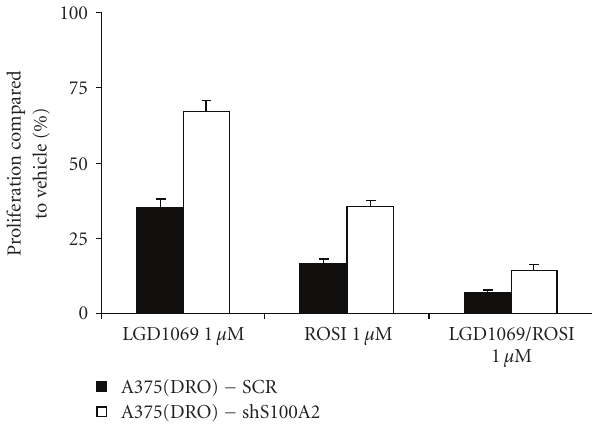
Figure 5: Knock down of S100A2 blunts the antiproliferative e ff ect of TZD and rexinoids in A375(DR) cells. A375(DRO), the SCR infected, and an shS100A2 infected subline were grown in 2% fetal bovine serum RPMI in the presence of 1 μ mol/L of LGD1069, TZD, or the combination for 6 days. Cell growth was analyzed using a nonradioactive cell proliferation assay. Proliferation was compared to that of cells grown in volume equivalent vehicle (DMSO—set at 100%). Proliferation was statistically significantly attenuated compared to the A375(DRO) SCR subline in all treatment conditions. Columns, mean; bars, SEM.